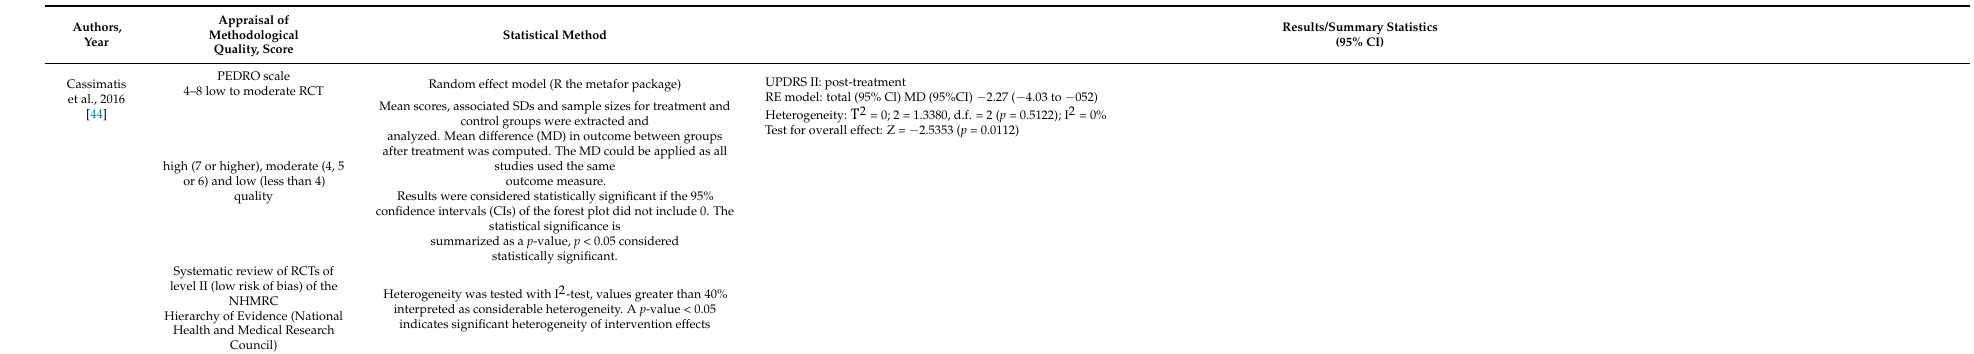
Table 3. Methods used in the included studies.